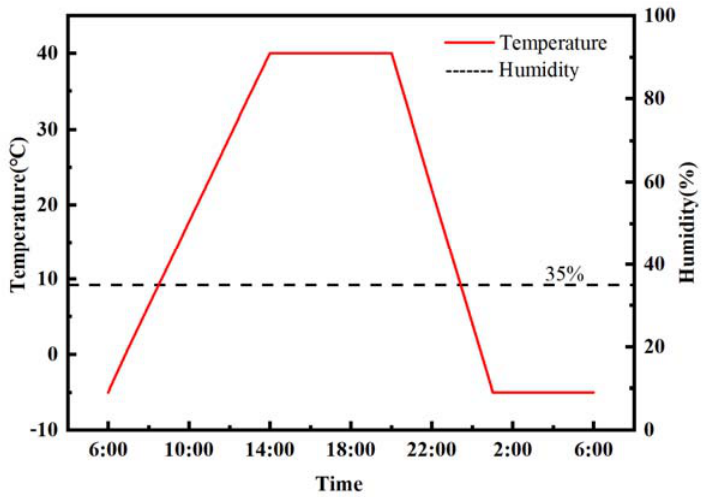
Figure 2. The detailed change process of humidity and temperature in one day in the environmen ‐ tal